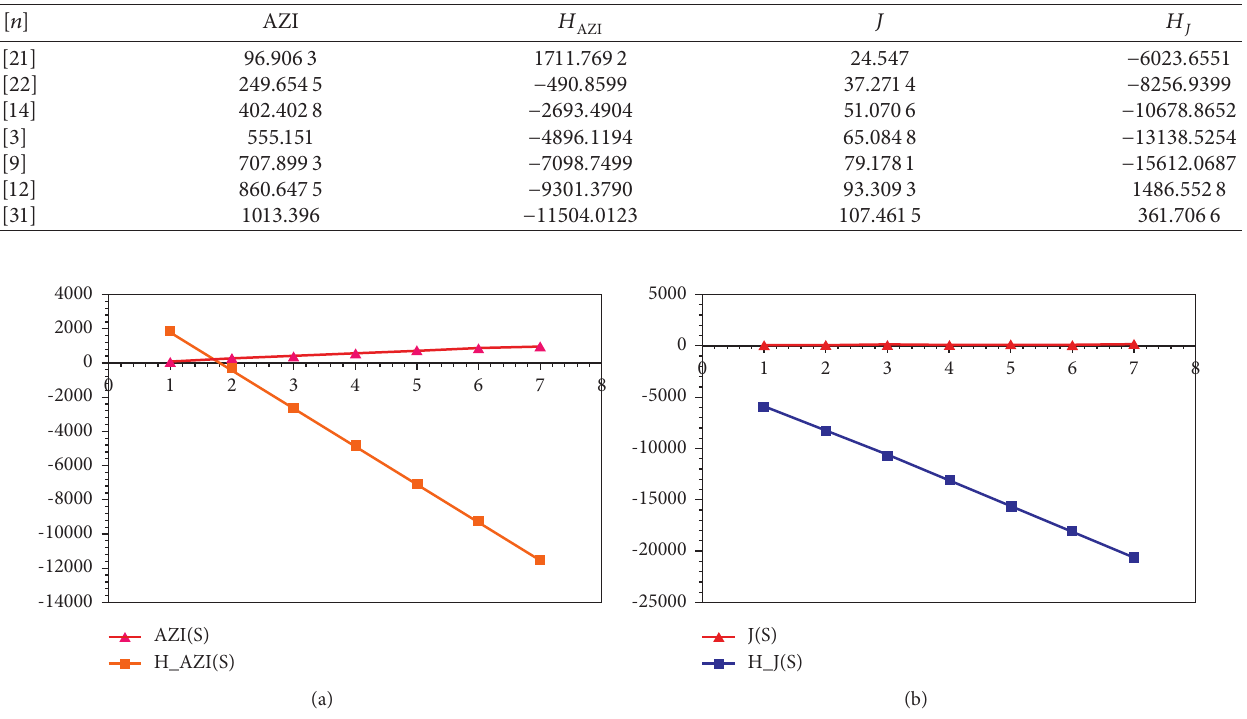
Table 8: Comparison of AZI and J indices with their respective heat of formation for GST − SL [ n ] .